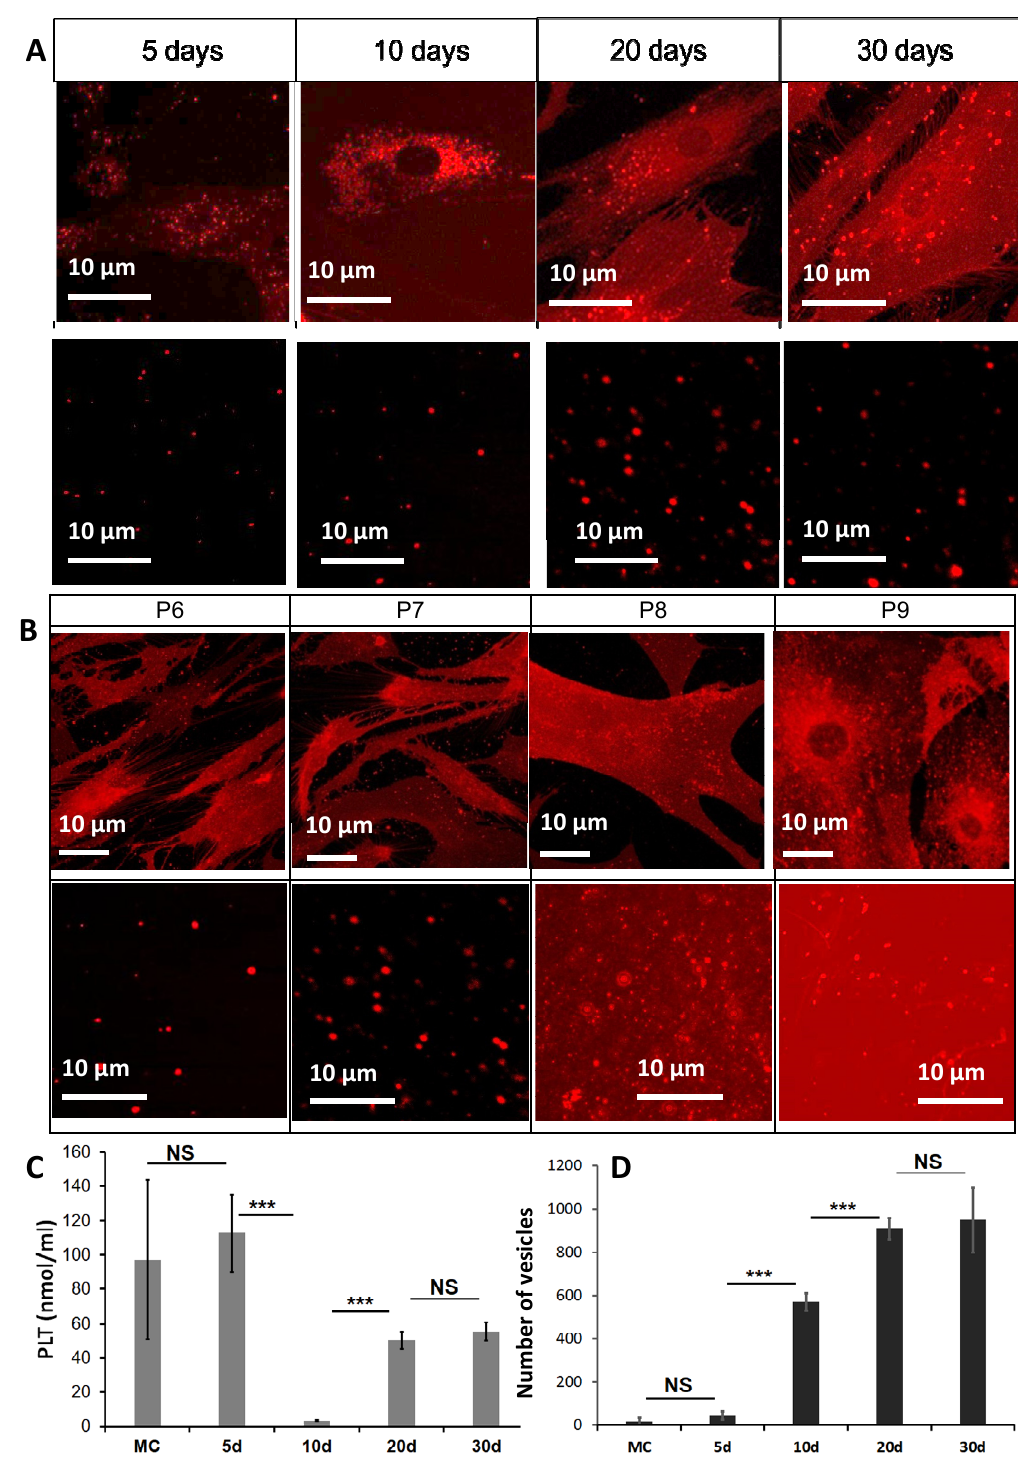
Figure 1. Selection of the most appropriate conditions for the structural and mechanical characterization. ( A ) Cells ( top ) and supernatants ( bottom ) confocal micrographs at 5, 10, 20, and 30 days of cell culture (X63 immersion oil microscope objective) after passage 6. ( B ) Cells ( top ) and supernatants ( bottom ) micrographs from passage 6 to 9 each after 20 days. Labeling of the different components was done by lipophilic fluorescent label “DiI” ( λ ex~549 nm). ( C ) PLT concentration (µg/mL) in the supernatant and ( D ) number of vesicles per image as a function of cell culture day. MC, medium of culture. Bars represent mean ± SD. *** p < 0.0001, and NS non-significant.